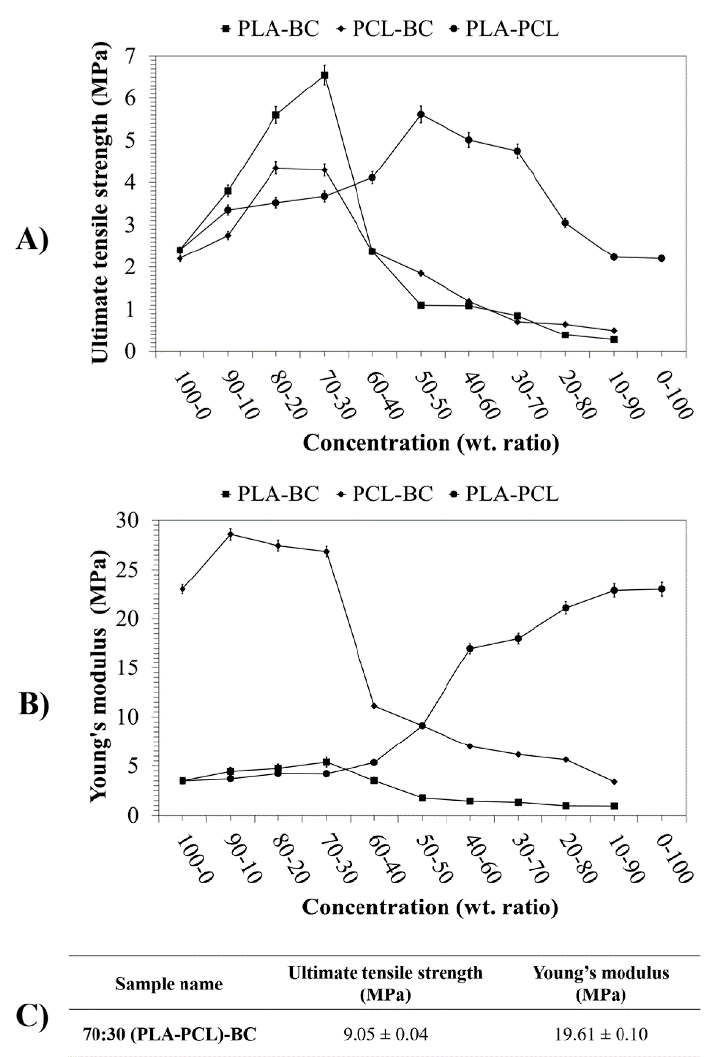
Fig. 5 Intensity of each ligament at 60 ◦ flexion